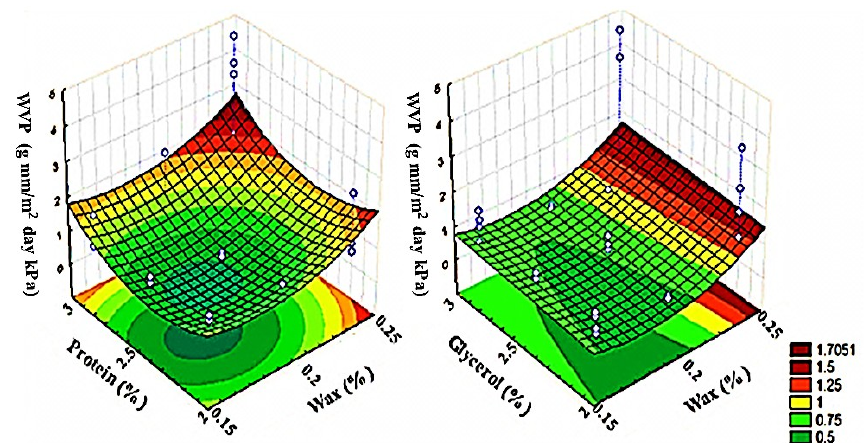
Figure 1. Response surface graph of Water Vapor Permeability (WVP) in films as a function of protein, wax, and glycerol